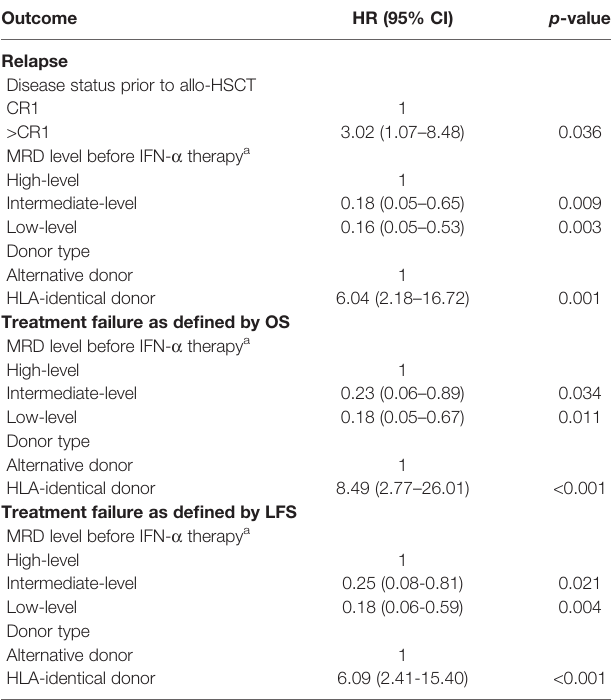
TABLE 3 | Multivariate analysis of risk factors for the 2-year clinical outcomes after preemptive IFN- a therapy in full analysis set. Outcome HR (95% CI) p -value Relapse Disease status prior to